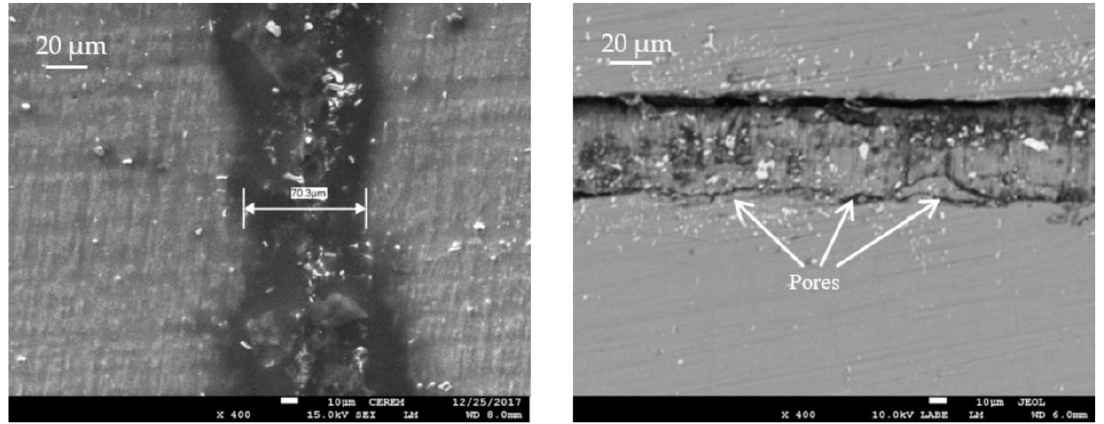
Figure 4. Effect of bonding time on TLP bonding [10]. Figure 4. E ff ect of bonding time on TLP bonding